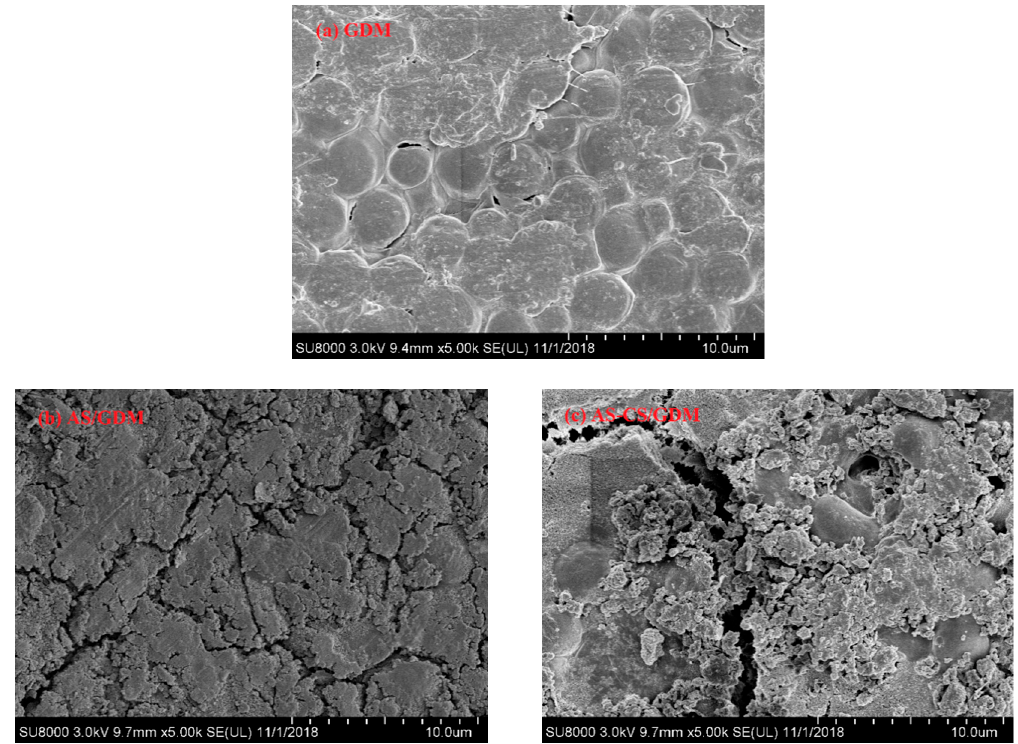
Figure 9. SEM images of the cake layer from the ( a ) GDM, ( b ) AS / GDM and ( c ) AS-CS / GDM